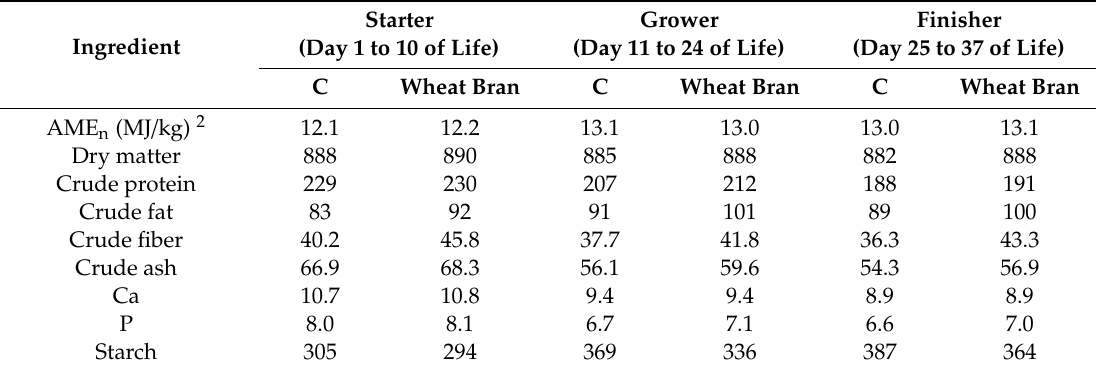
Table 2. Analyzed nutrient content of experimental diets (g / kg as fed) 1